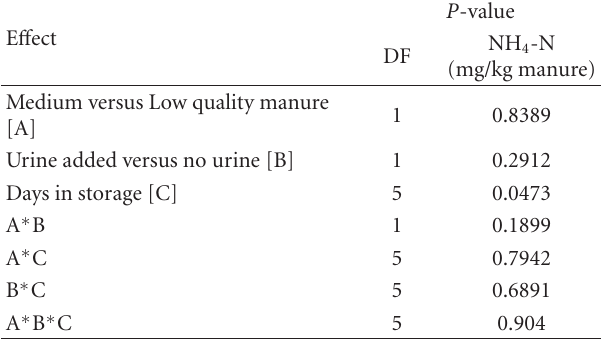
Table 5: ANOVA results for NH 4 -N concentration (mg NH 4 - N/kg manure, DM basis) of manure in storage in the rainy season experiment. Fixed e ff ects are the manure quality (Medium versus Low quality), the presence or absence of urine in the manure, and the number of days the manure was incubated (0, 6, 12, 18, 24, or 30 days). Terms for the interaction between fixed e ff ects are denoted by fixed e ff ects terms separated by an asterisk ( ∗ ). DF represents the degrees of freedom of the